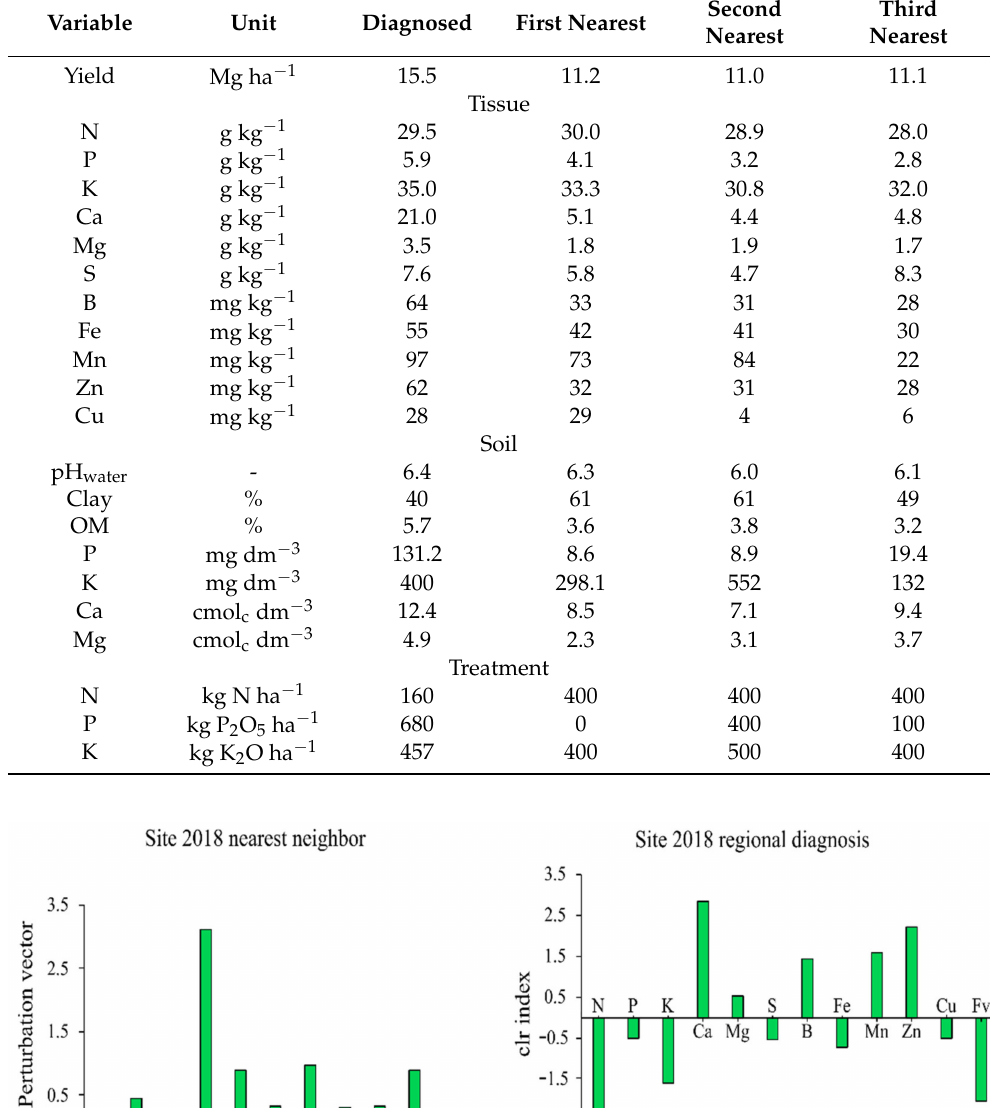
Table 5. Difference in yield and soil and tissue compositions in the diagnosed specimen in 2018 and its closest nutritionally balanced neighbors yielding more than 11 Mg ha − 1 .